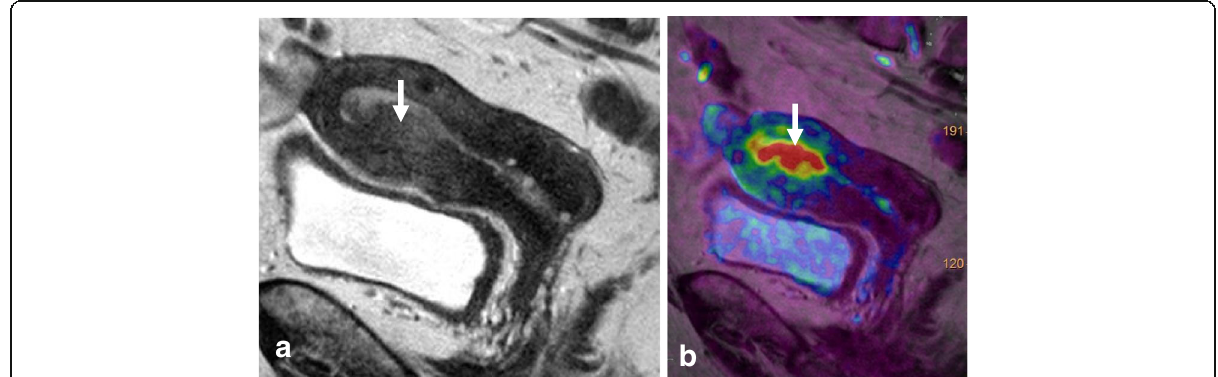
Fig. 3 FIGO IA endometrial tumor (arrows) with myometrial invasion of < 50% is isointense in T2WI images ( a ) and well-delineated in fused T2WI- DWI images ( b )